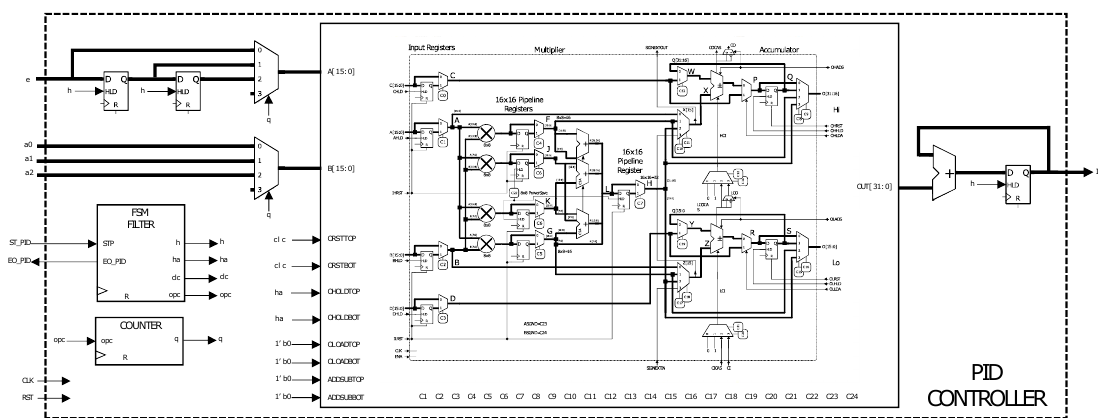
Figure 6. Proportional-Integral-Derivative (PID) controller implemented in the FPGA.